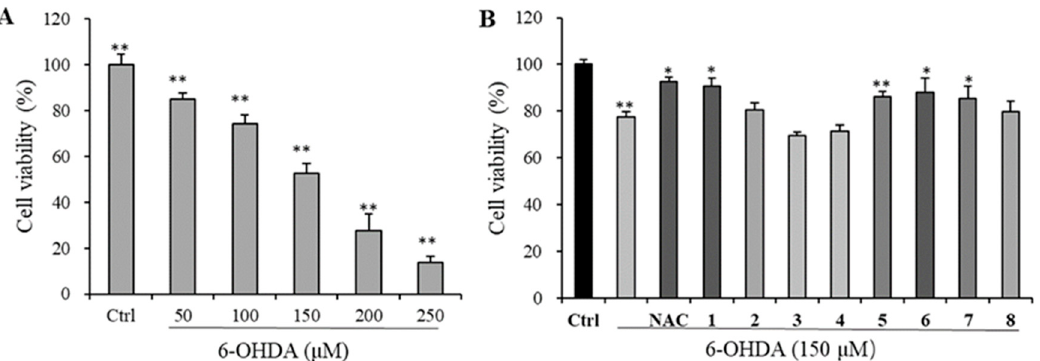
Figure 4. Neuroprotective evaluation of iridoids 1 − 8 in PC12 cells. ( A ) The cell viability of PC12 cells upon 6-OHDA treatment in the concentration range of 50–250 μ M; ( B ) neuroprotective effects of 1 − 8 at 50 μ M against 6-OHDA-induced PC12 cell injury. Data are expressed as mean ± SD from triplicate experiments. * p < 0.05, ** p < 0.01, compared with the control group.